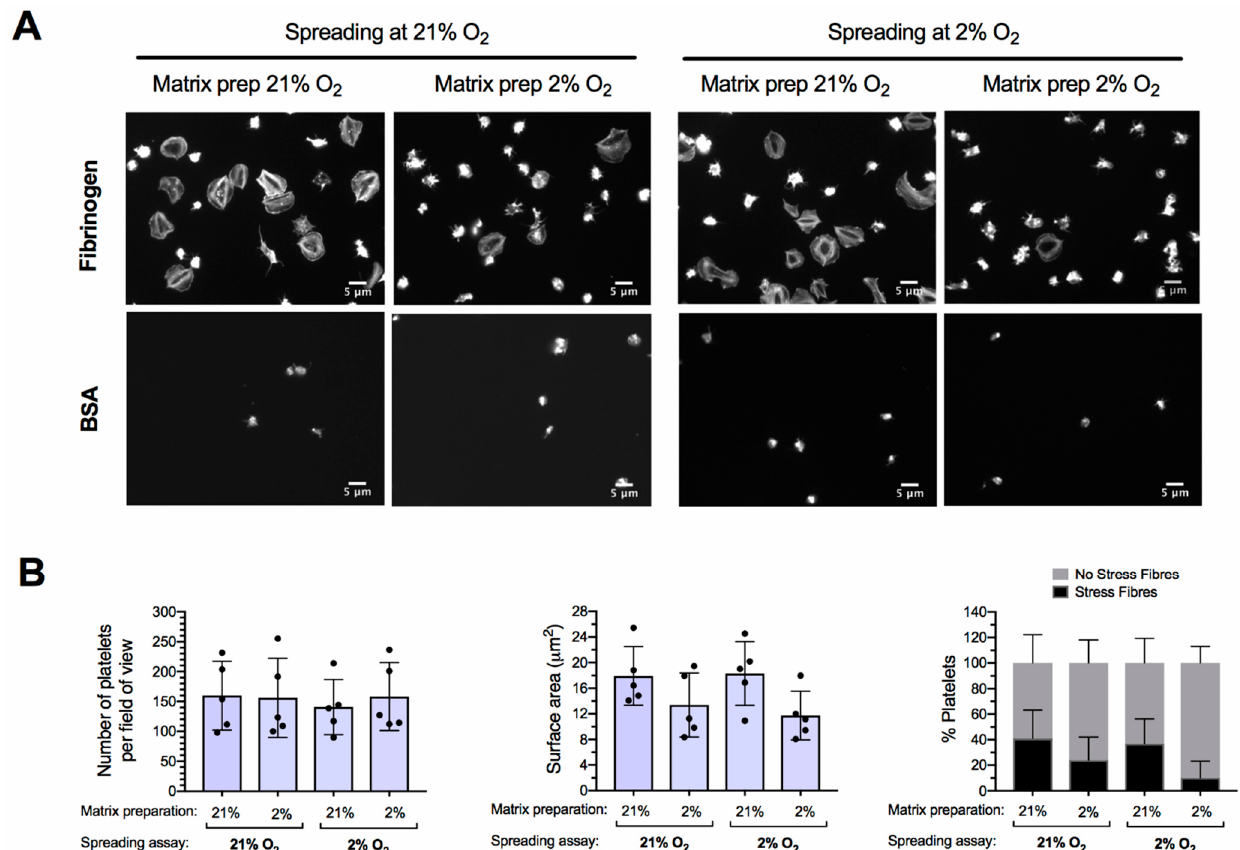
Figure 3. Effect of experimental conditions on platelet spreading on fibrinogen at 2% oxygen. Washed platelets at 2.5 × 10 8 platelets/mL were incubated at 2% oxygen or atmospheric conditions for 90 min before being diluted to 2 × 10 7 platelets/mL with modified Tyrode’s buffer pre-equilibrated to the same oxygen percentage and allowed to spread for one hour on immobilised fibrinogen or BSA. In each case, coverslips freshly coated with fibrinogen or BSA at 2% and 21% oxygen using overnight oxygen pre-equilibrated culture plates were tested. After the incubation time, unbound platelets were washed away and samples were fixed with 4% paraformaldehyde. At this point, samples exposed at 2% oxygen were removed from the hypoxia chamber for permeabilisation, FITC-phalloidin staining and visualisation by fluorescence microscopy. ( A ) Representative images of one out of 5 replicates are shown. ( B ) Mean ± SD of number of adhered platelets, surface area, and percentage of platelets with stress fibres (n = 5). Statistical significance was calculated using two-way ANOVA, followed by Tukey’s multiple comparison correction, with p ≤ 0.05 considered significant. No statistically significant differences were detected.